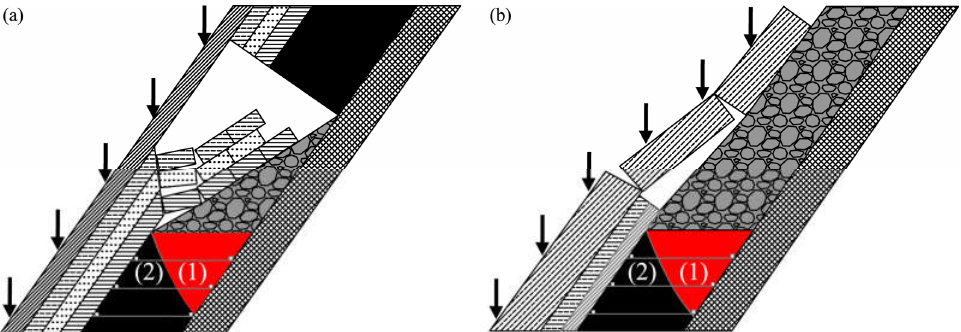
Figure 5. The stress redistribution mechanism of the steep and extra-thick coal seam: ( a ) the pressure arch structure stage and ( b ) the hinge structure stage. In both figures: (1) denotes the pressure relief zone, and (2) denotes the stress concentration zone.